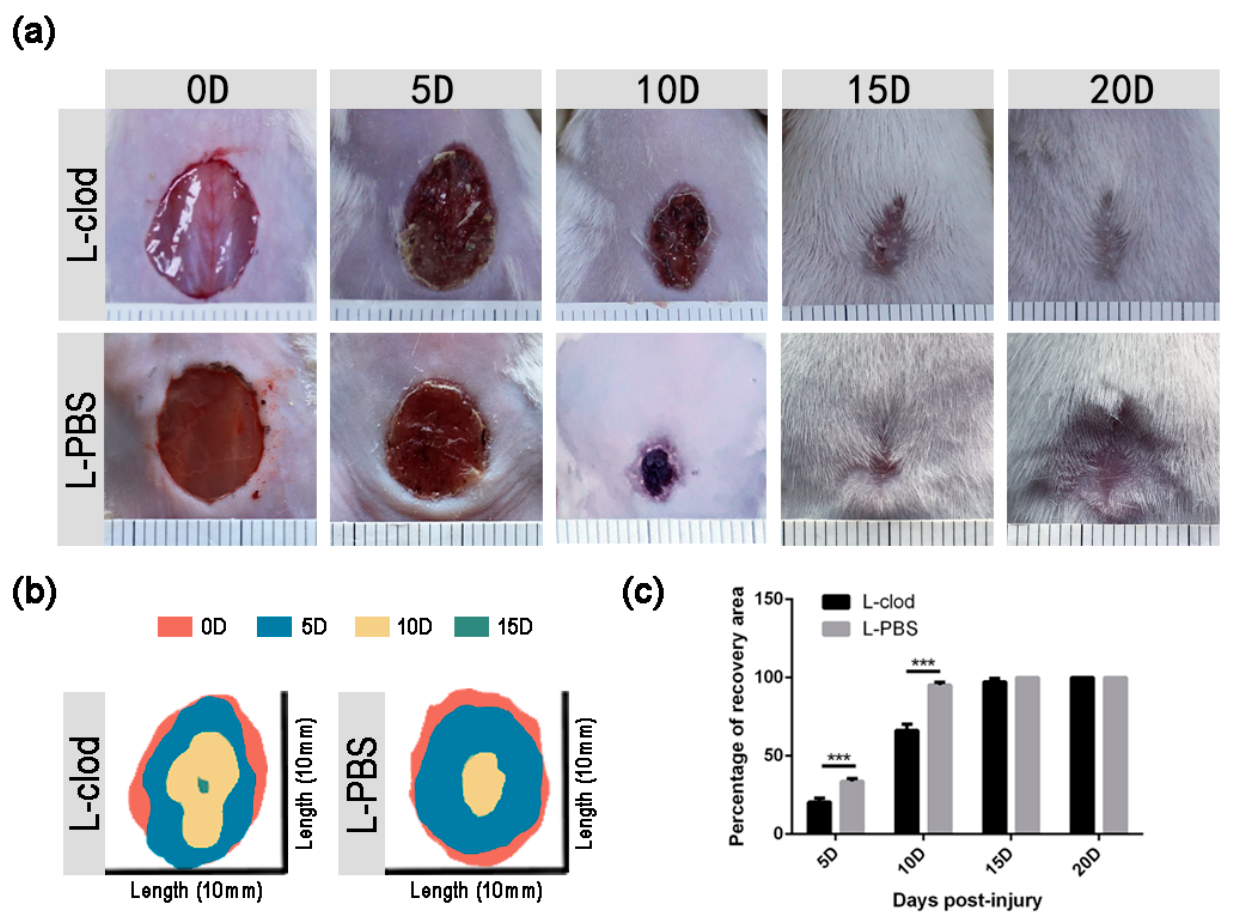
Figure 2. Wound healing in L-clod and L-PBS-injected mice. ( a ) Macroscopic appearance of wound sites from mice treated with either L-clod or L-PBS at different time points. ( b ) Schematic diagram of injury site changes over time. ( c ) Quantification of the recovery rate. The open wound area was measured using Image J and represented as percentage of recovery area as described in the Materials and Methods section ( n ≥ 3. *** p < 0.001. Data presented as mean ± SD). Table 1. Statistics of healing rate in L-PBS- and L-clod-injected mice. Groups Time Points p Value L-clod-Injected L-PBS-Injected